Question: Which kind of chart has been used to present this data?
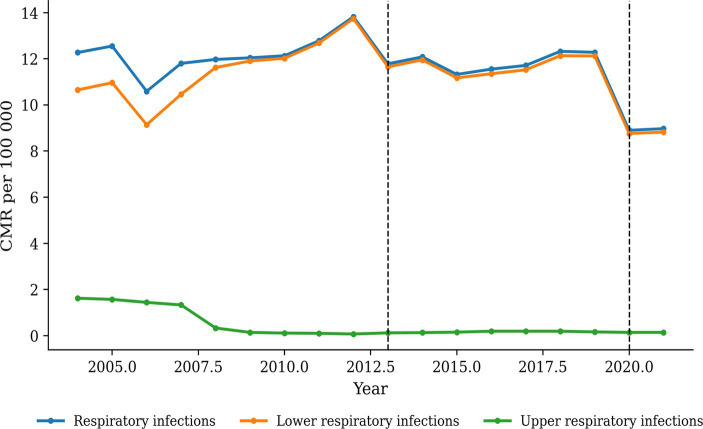
Answer: line